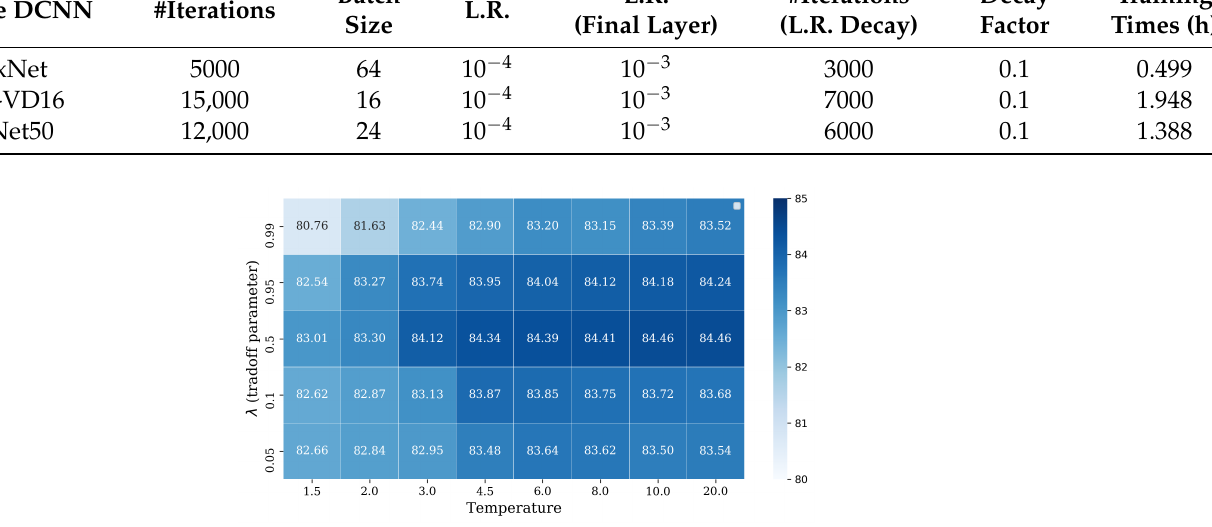
Figure 9. Evaluation of the temperature T and tradoff λ as the hyper-parameters for the AlexNet- based RIR-net on the NWPU dataset (training ratio = 10%). The testing classification results are measuring in terms of overall accuracy (%). The testing accuracy of the model with the cross-entropy criteria only is 82.37%.